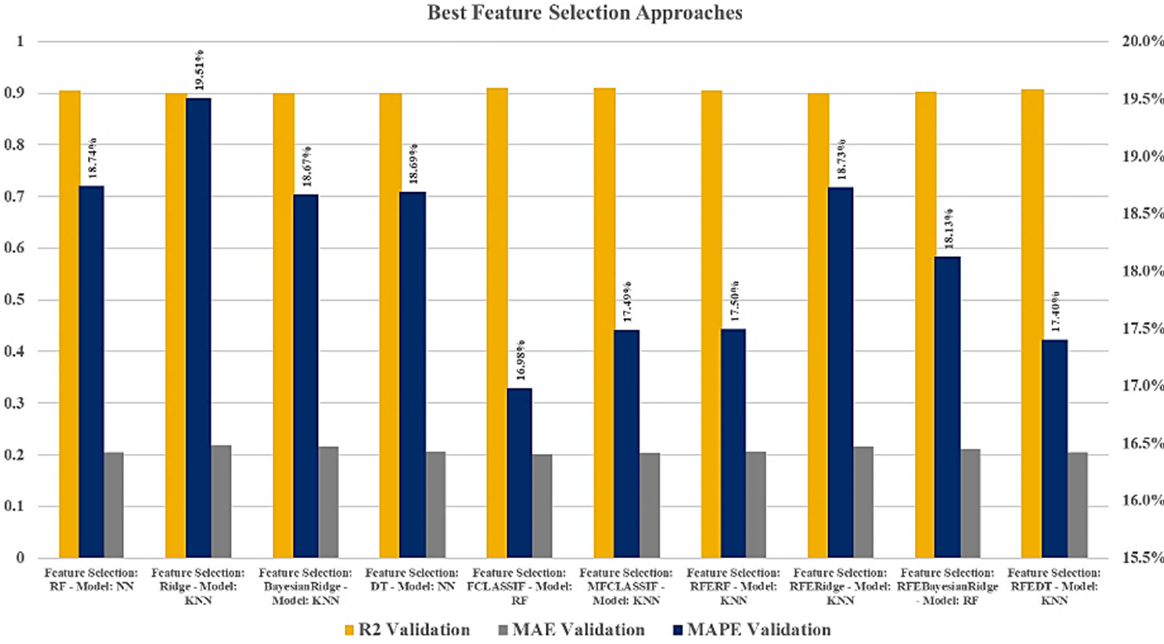
Figure 7. Comparison of feature selection approaches using validation data set for total passenger vehicles.